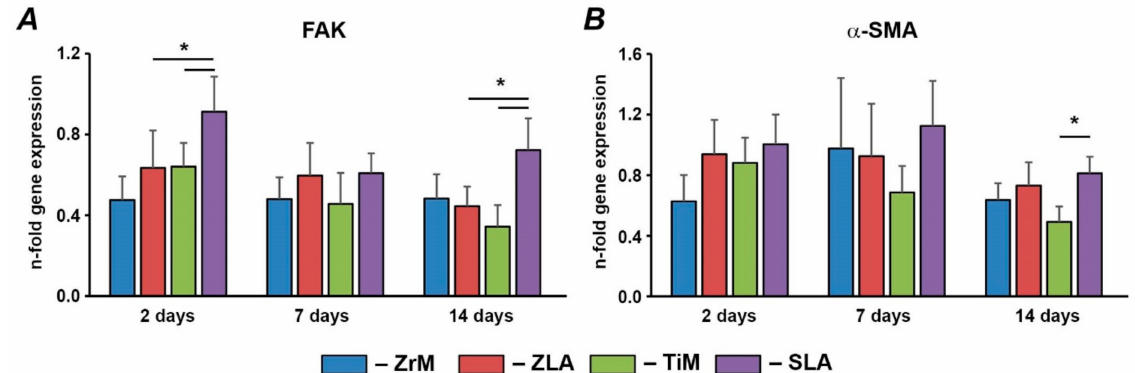
Figure 4. Gene expression of FAK and α -SMA in hGFs grown on different surfaces. hGFs were seeded on one of the following surfaces: smooth zirconia machined surface (ZrM), moderately rough zirconia surface (ZLA), smooth machined titanium surface (TiM), or moderately rough titanium surface (SLA). Expression of ( A ) FAK and ( B ) α -SMA in hGFs grown on ZrM, ZLA, TiM and SLA at 2, 7, and 14days. Y -axis represents the n -fold expression levels of the target gene in relation to the cells in the TCP group (control) calculated by the 2 − ∆∆ Ct method. Data are presented as mean ± SEM of 8 independent experiments with hGFs of 8 different donors ( n = 8), * significant difference between groups as tested by Wilcoxon test ( p <